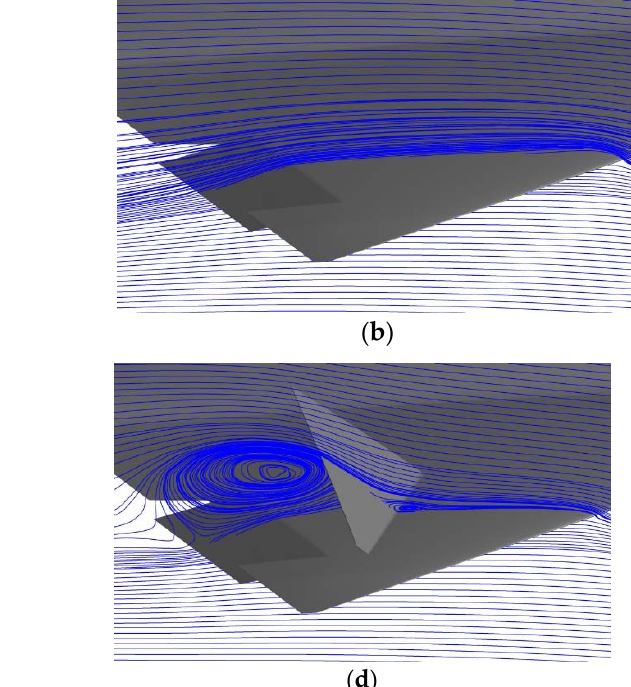
Figure 12. Section streamlines for four configurations, Ma = 0.2, Re = 3.98 × 10 7 , α = 6°: ( a ) Baseline;